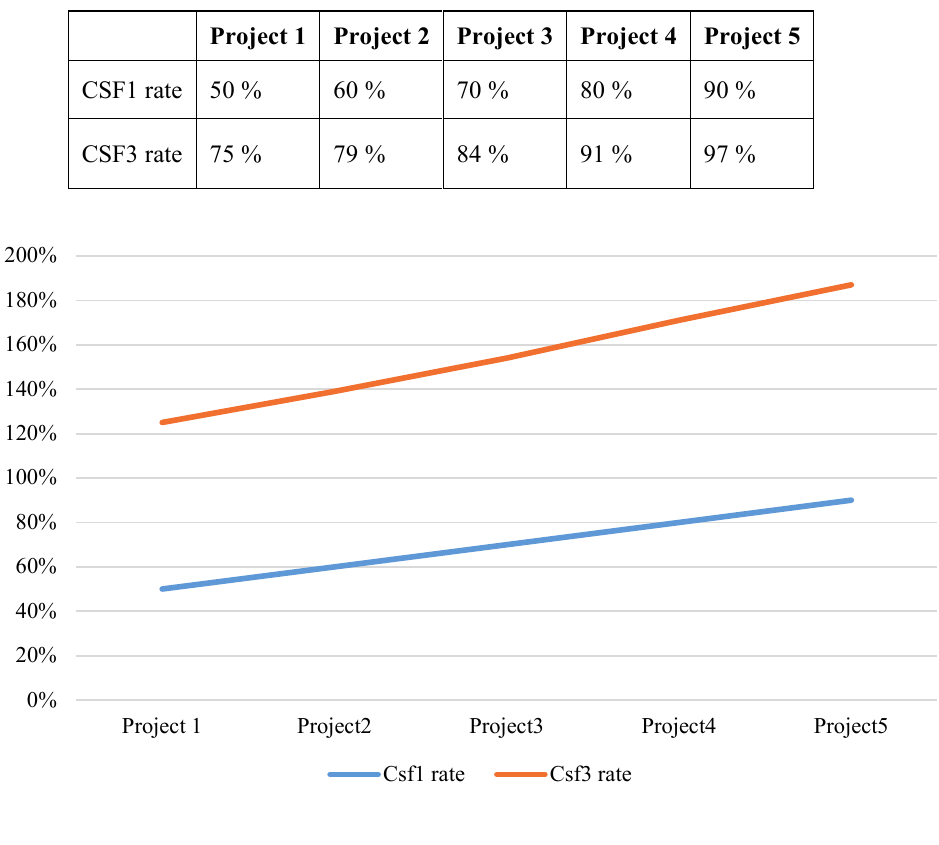
Fig. 5. Trends in the correlation between CSF1 and